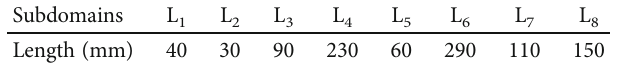
Figure 9: Objective function vs. number of iterations.